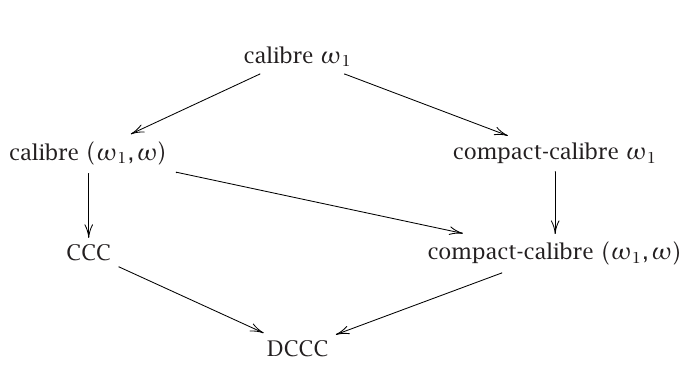
Figure 1.1 . Relative strengths of the conditions for arbitrary